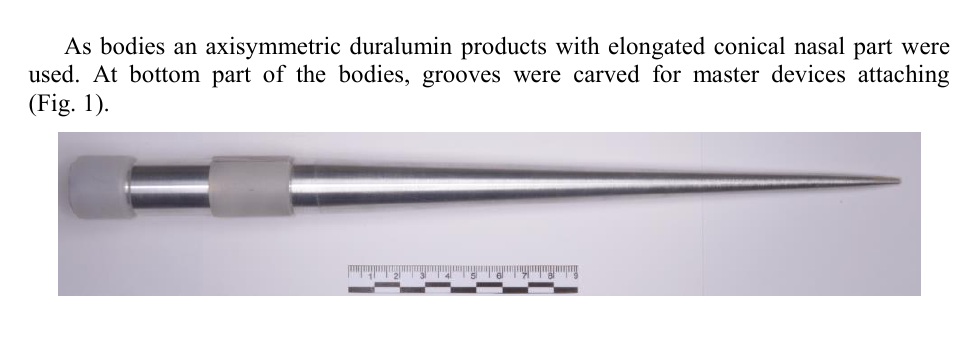
Fig. 1. Photo of elongated duralumin body